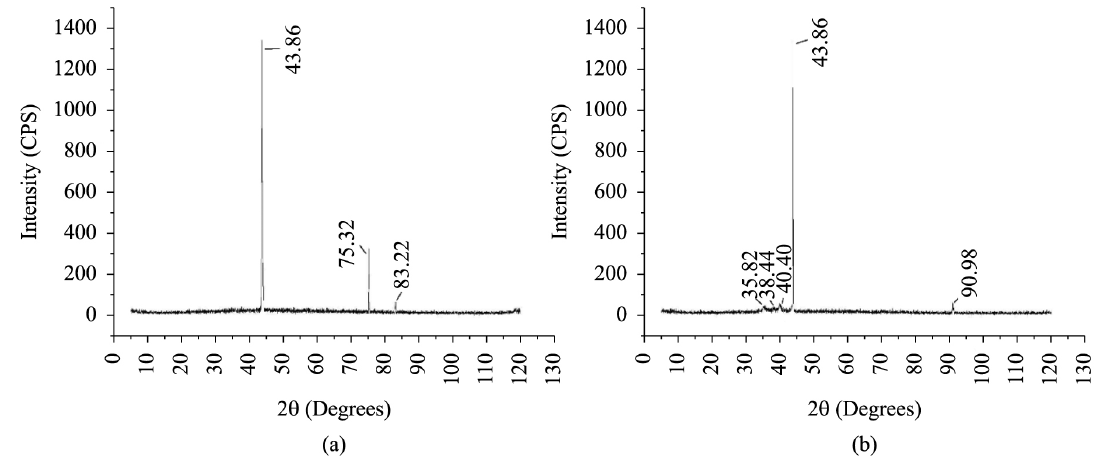
Figure 3. Diffractogram of (a) uncoated diamonds and (b) Ti-coated diamonds, prior to heat treatment.